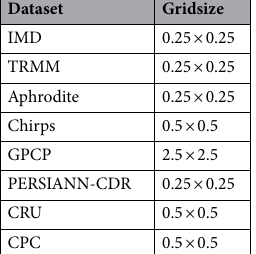
Table 2. List of observation datasets used in this study.